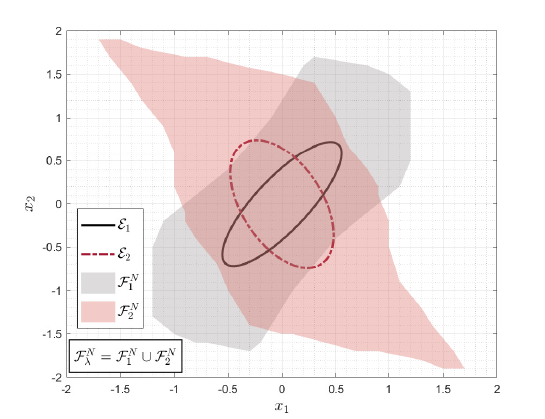
Figure 2. The invariant set E i and an estimate of the corresponding region of attraction F N Since E λ ∈ E 1 ∪ E 2 , a larger region of attraction can be obtained, i.e., F N